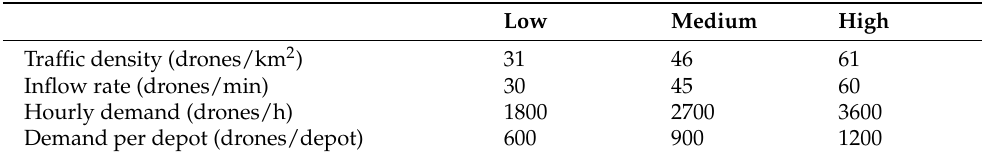
Table 2. Traffic density characteristics of the three demand scenarios for the simulation area of Manhattan, New York City, network consisting of an area of 59.1 km 2